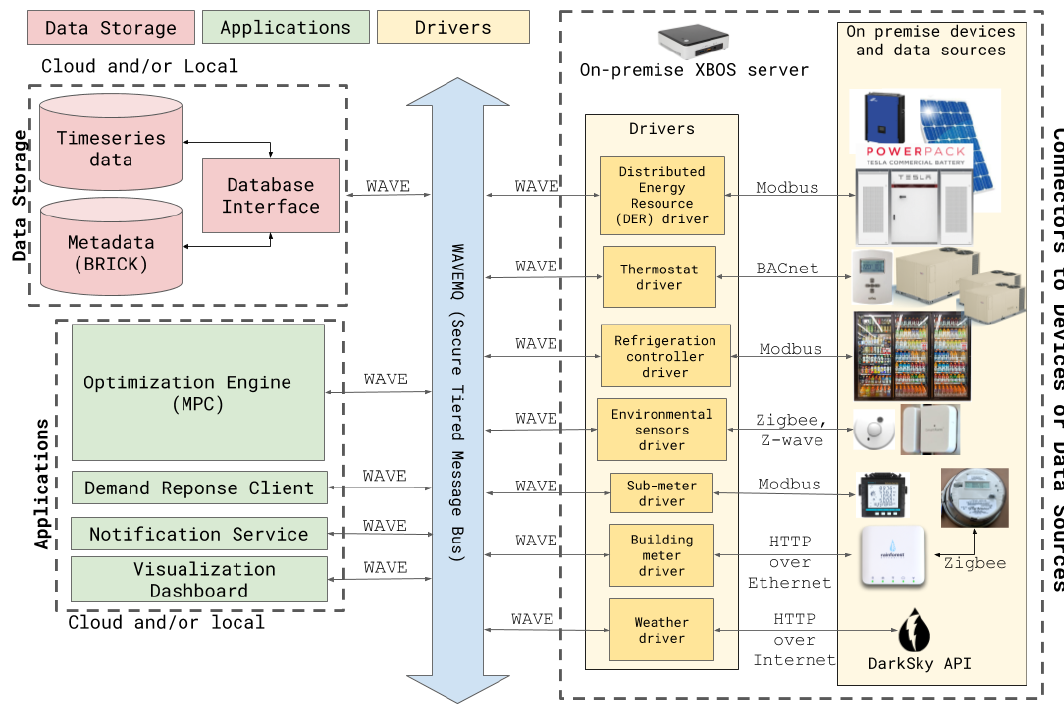
Figure 1. Software architecture diagram of the Solar+ Optimizer